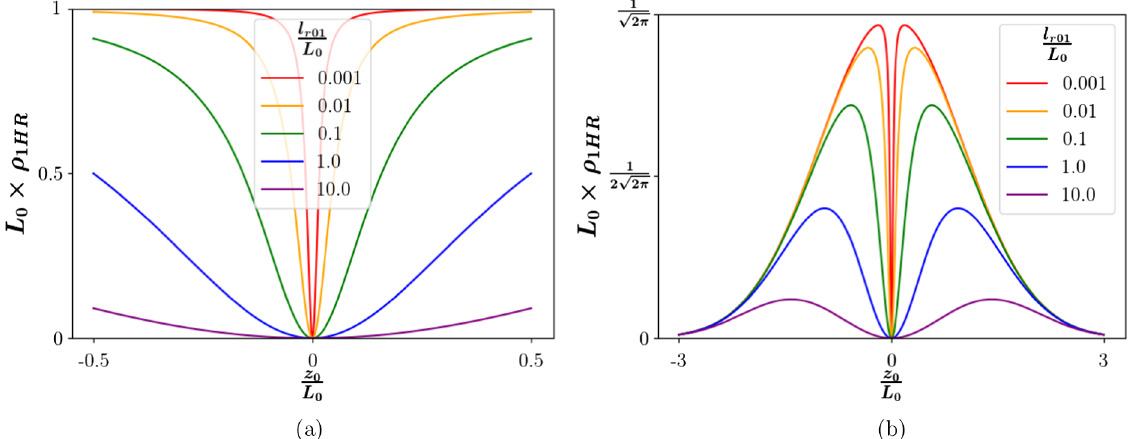
FIG. 1. Shape of the planar symmetric asymptotic density for (a) uniform and (b) Gaussian initial distributions. L 0 represents the initial ϵ 0 mc 2 width of the distribution, l is the length scale associated with the density of the particles, and Q is the charge per unit area r 01 ¼ tot ; 1 qQ tot ; 1 of the distribution as described in the text. Notice that these graphs are independent of the exact choices of L 0 . Further notice the for the uniform distribution. Finally note the fact that the distribution quadratic like behavior in the middle as well as at large values of l r 01 L 0 is small. What is not displayed is that the maximum peak is approaches the original distribution at its maximum value when l r 01 L 0 when l r 01 is proportional to 1 l r 01 L 0